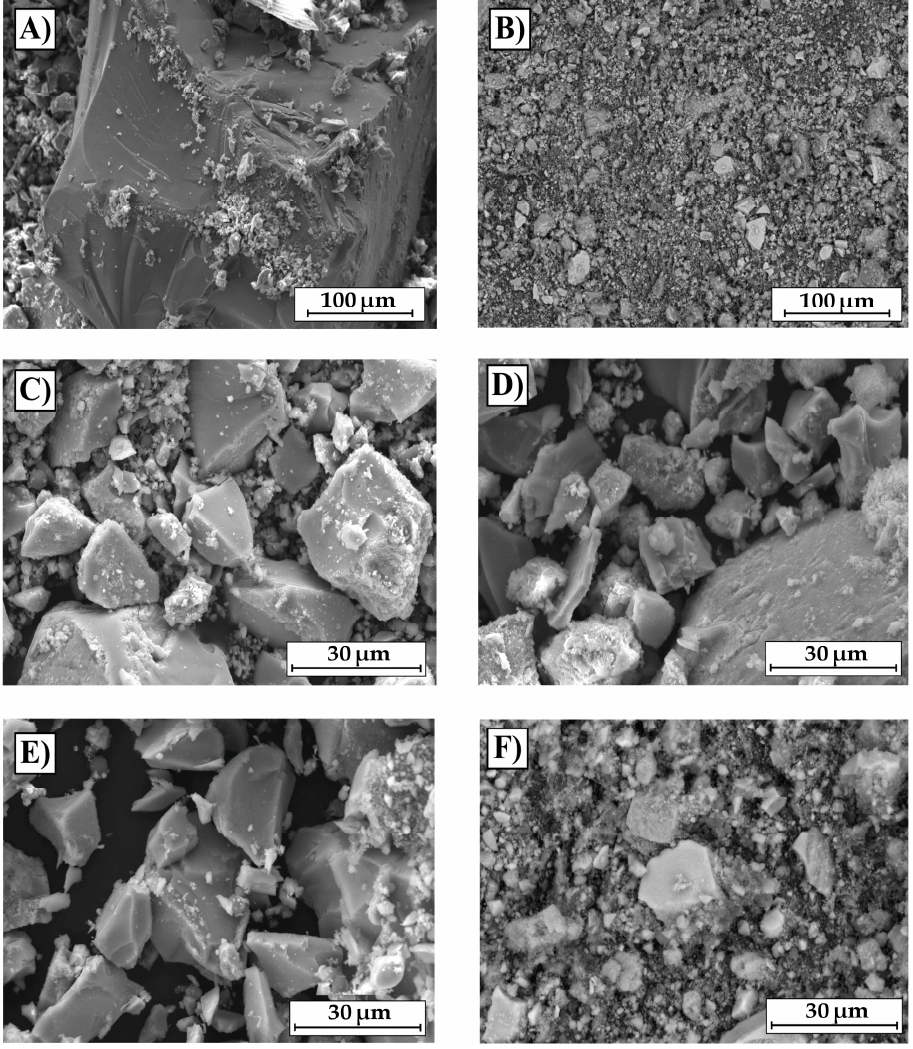
Figure 5. Scanning electron microscopy (SEM): ( A ) fresh NbPO, ( B ) fresh ZrPO, ( C ) spent NbPO, ( D ) spent ZrPO, ( E ) washed NbPO and ( F ) washed ZrPO.